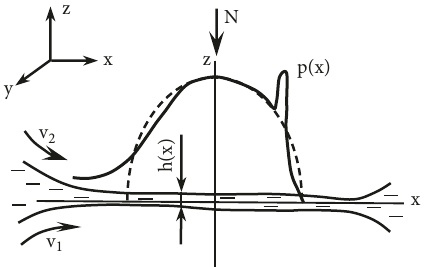
Figure 3: Scheme of the pressure distribution in the contact area of the cylindrical surfaces in elastohydrodynamic